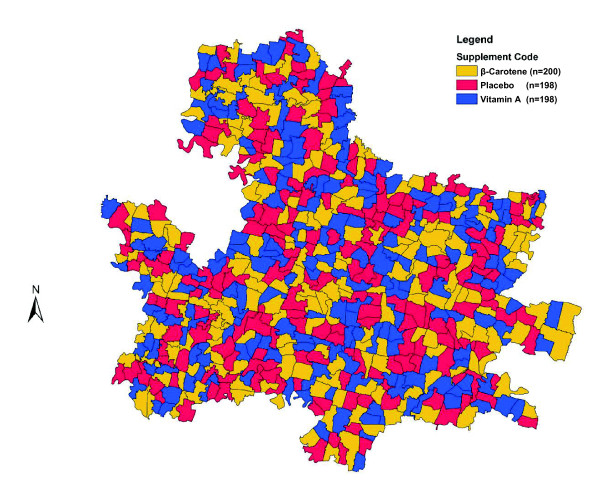
Study area map illustrating the randomized distribution of treatment allocation to study sectors.